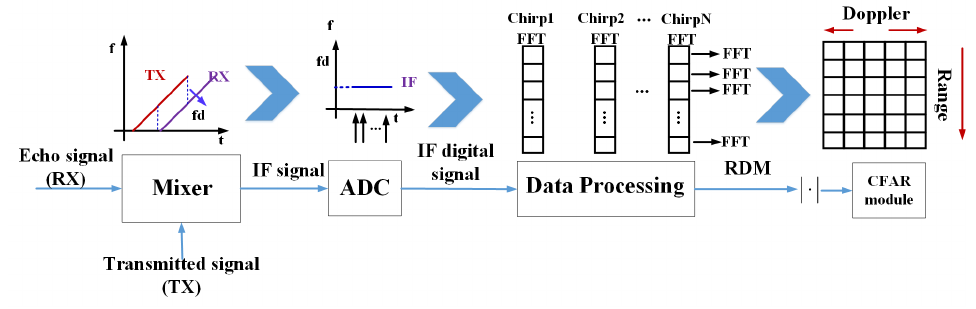
Figure 2. Radar signal